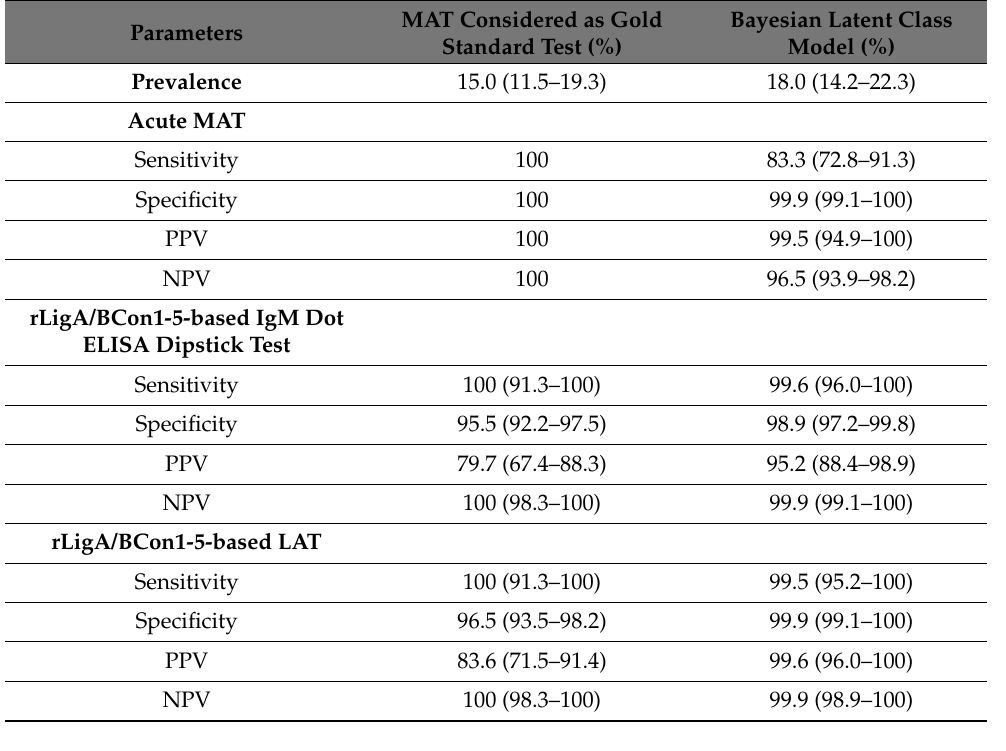
Table 2. Comparison of the diagnostic accuracies of single acute MAT with IgM dot ELISA dipstick test and latex agglutination test by considering MAT as reference/gold standard as well as imperfect test as in